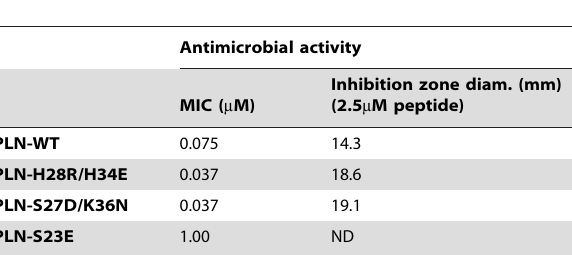
Table 2. Antimicrobial activity of wild-type and mutant plantaricin peptides against Listeria innocua